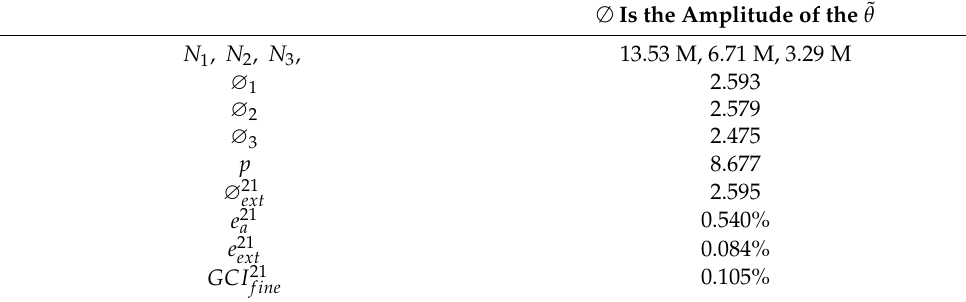
Table 6. Calculations of discretization